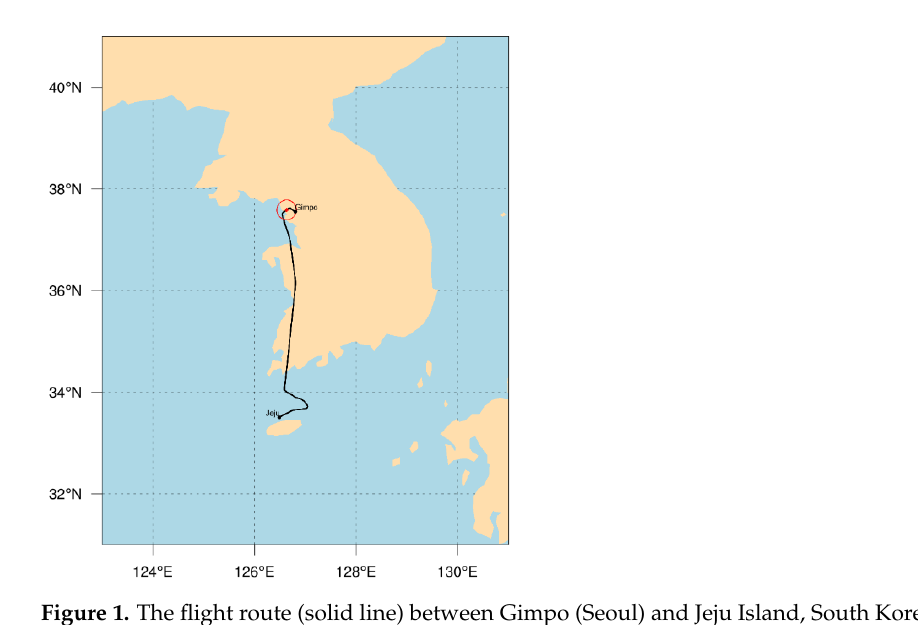
Figure 1. The flight route (solid line) between Gimpo (Seoul) and Jeju Island, South Korea, and the observed location of the plane (red dot) at 05:42 UTC on 28 October 2018.